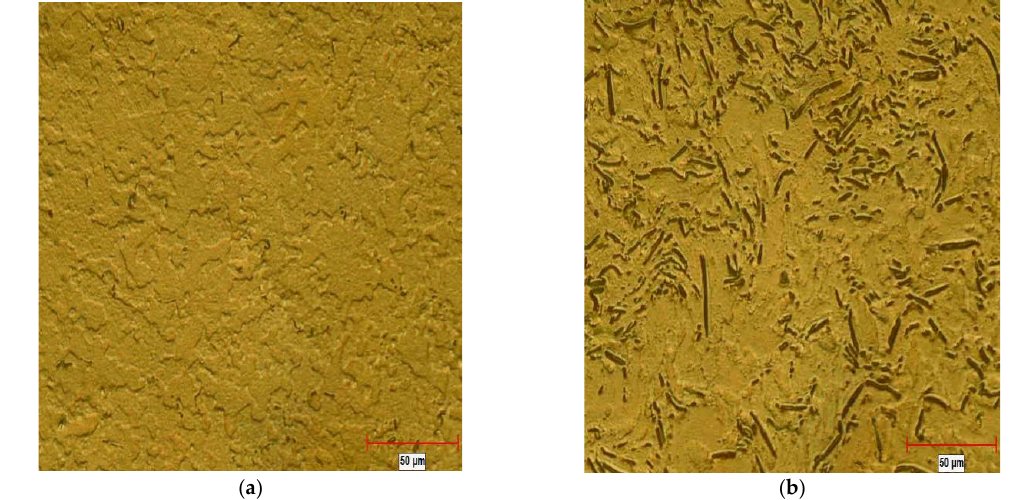
Figure 5. Optical microscopy images of a grain of ( a ) pure aluminum and ( b ) Al-GNP nanocomposite.